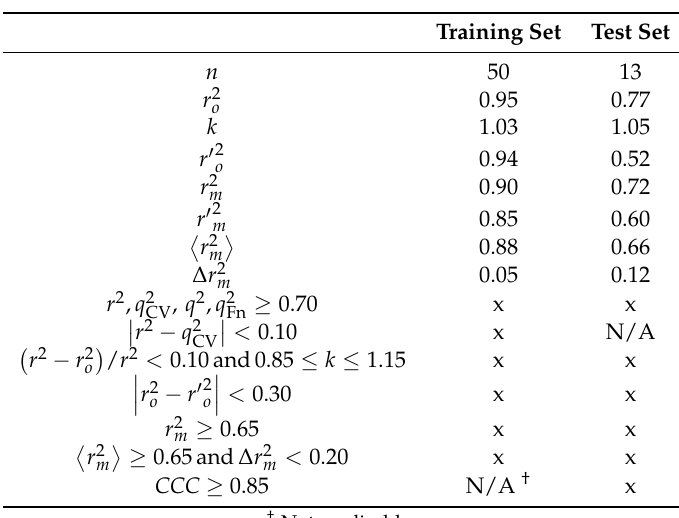
Figure 3. Residual vs. the log ER predicted by HSVR in the training set (solid circle) and test set (open square). Table 4. Validation verification of HSVR based on prediction performance of those molecules in the training set and test